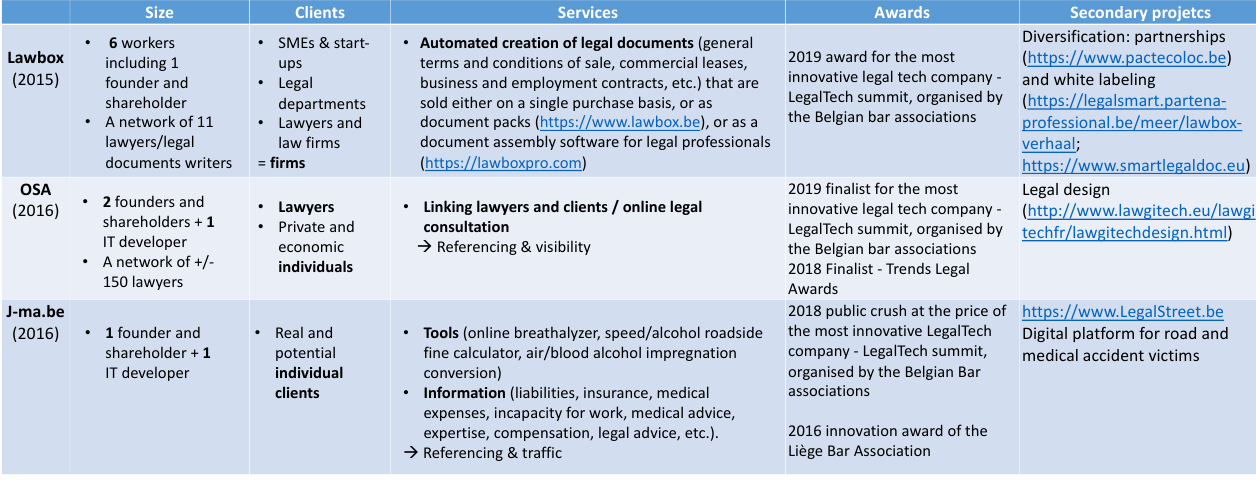
OSA: Online Solution